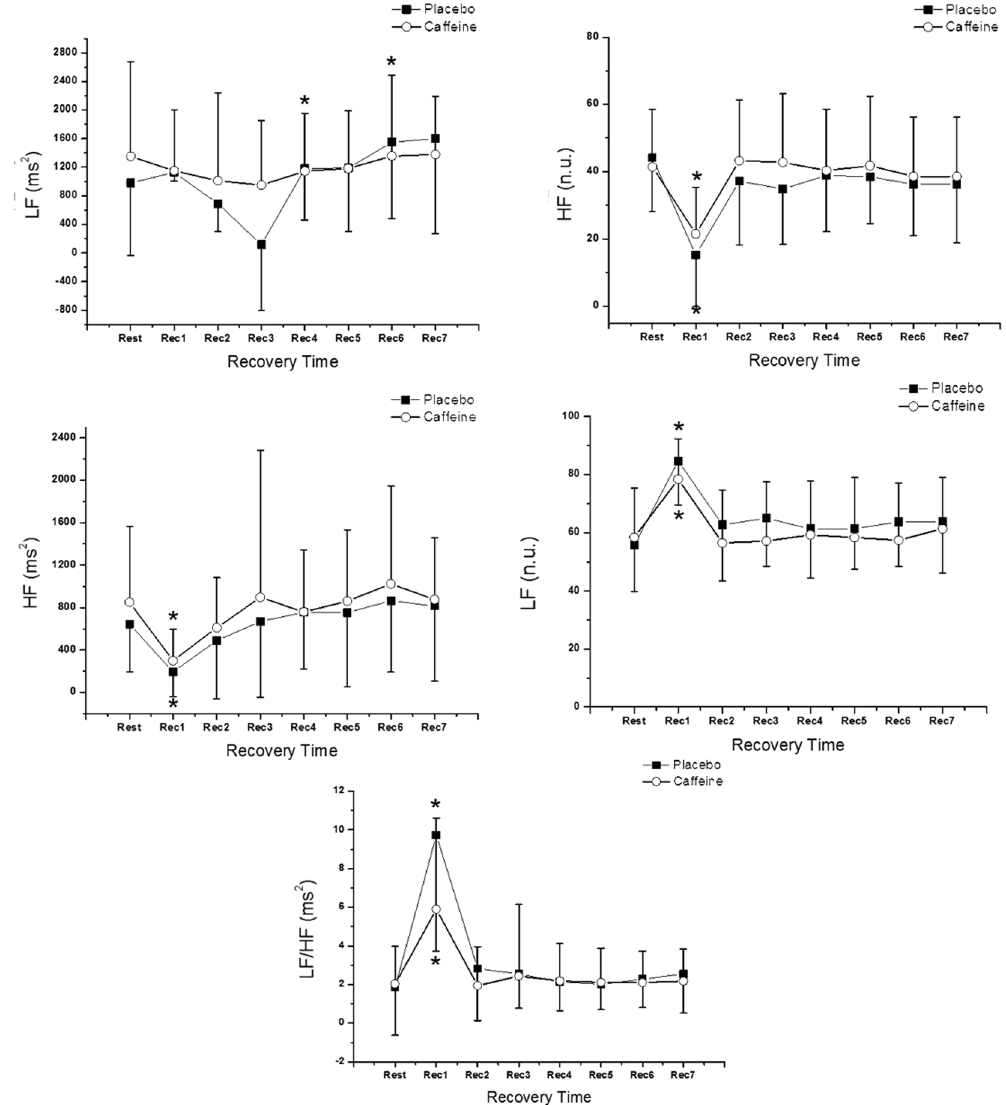
protocol with significant difference in relation to rest (Friedman test followed by the Dunn test, p <